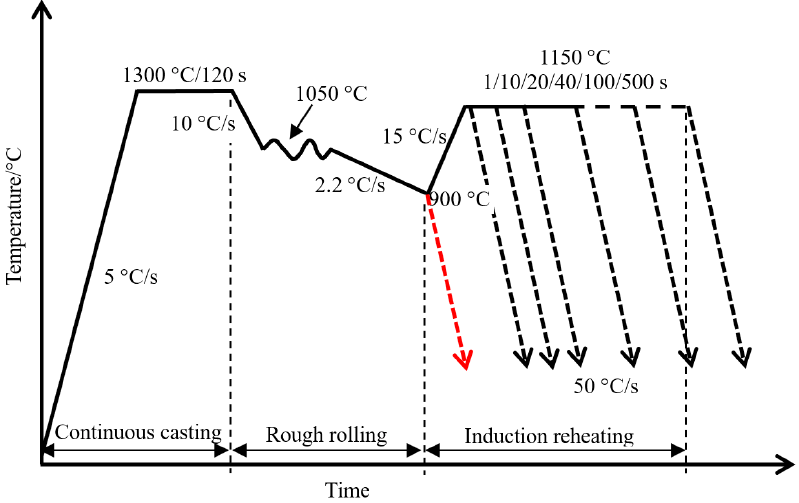
Figure 1. Process specification of the experimental steel by Gleeble-3500 thermal simulator.